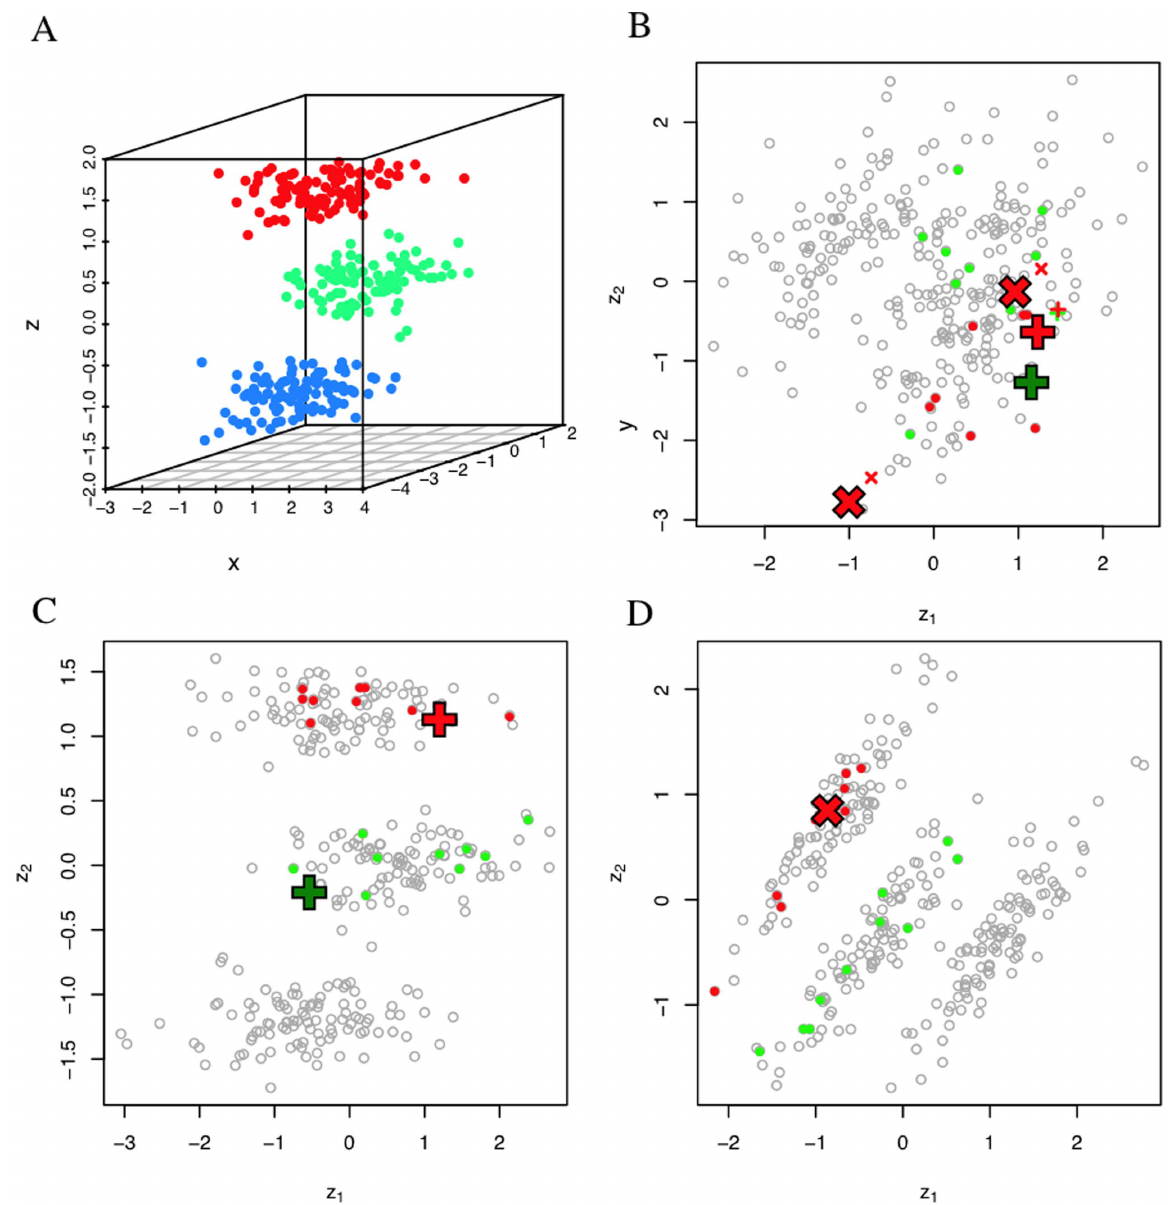
Figure 4. V2PI with PCA. Figure A displays the simulated data in three dimensions. Observations in red, green, and blue denote groups 1, 2, and 3 respectively. Figure B displays the PCA projection of the simulated data with 20 observations (that were selected at random) highlighted. Again, red and green points represent observations in groups 1 and 2 respectively. Figures C and D show updated displays after an adjustment to Figure B. Figure C is the result of moving points marked by ‘ z ’ in Figure B apart and Figure D is the result of moving the points marked by ‘ | ’ in Figure B together. Notice that both adjusted visualizations capture the clustering structure.